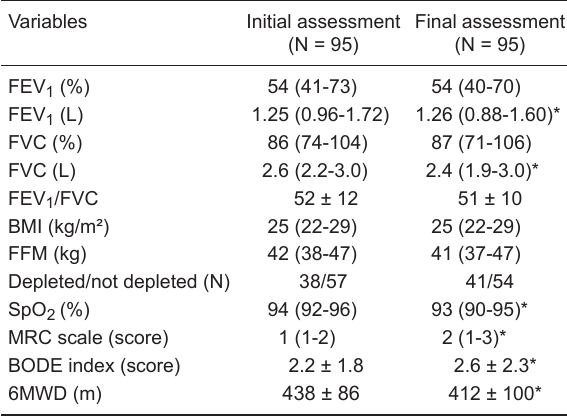
Table 3. Characteristics of patients with chronic obstructive pul- monary disease followed up over a 3-year